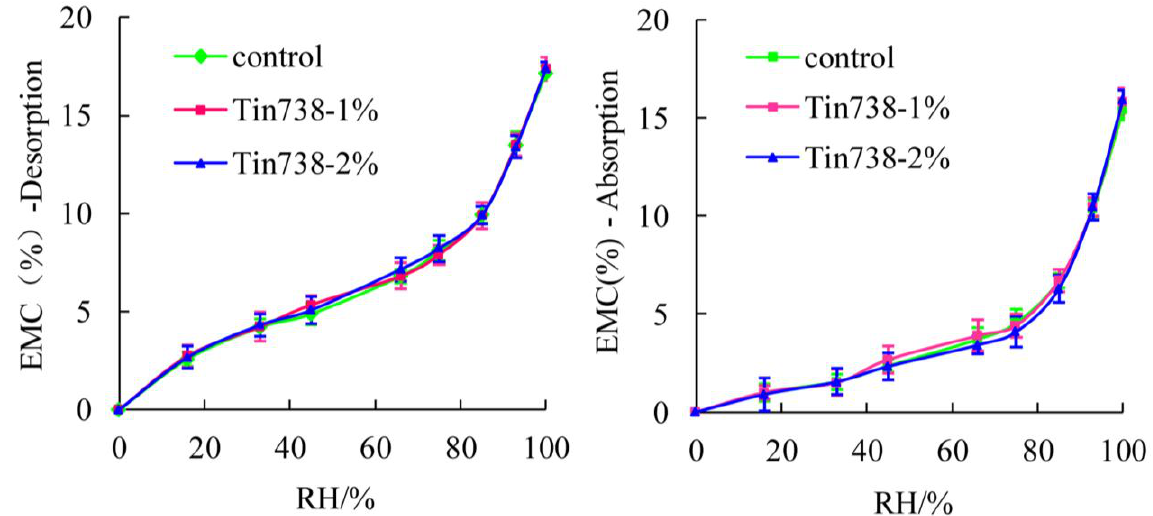
Figure 3. Effects of UV stabilizers Tin738 on EMC of WPCs.